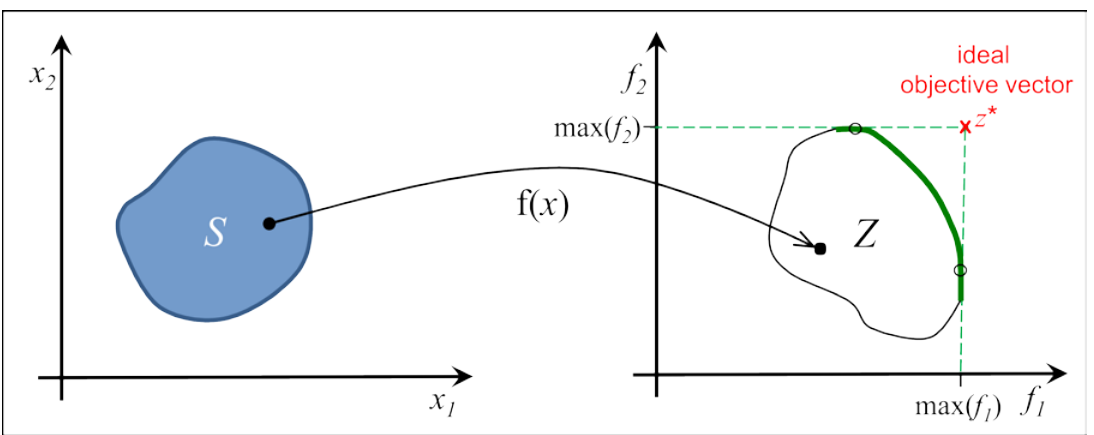
Figure 1. Feasible region S and its image, the feasible objective region Z for n = k = 2. The set of weakly Pareto optimal solutions is shown as a bold green line in the diagram on the right. The subset of Pareto optimal solutions is the part of the green line between the black circles. The ideal objective vector z * consists of the upper bounds of the Pareto